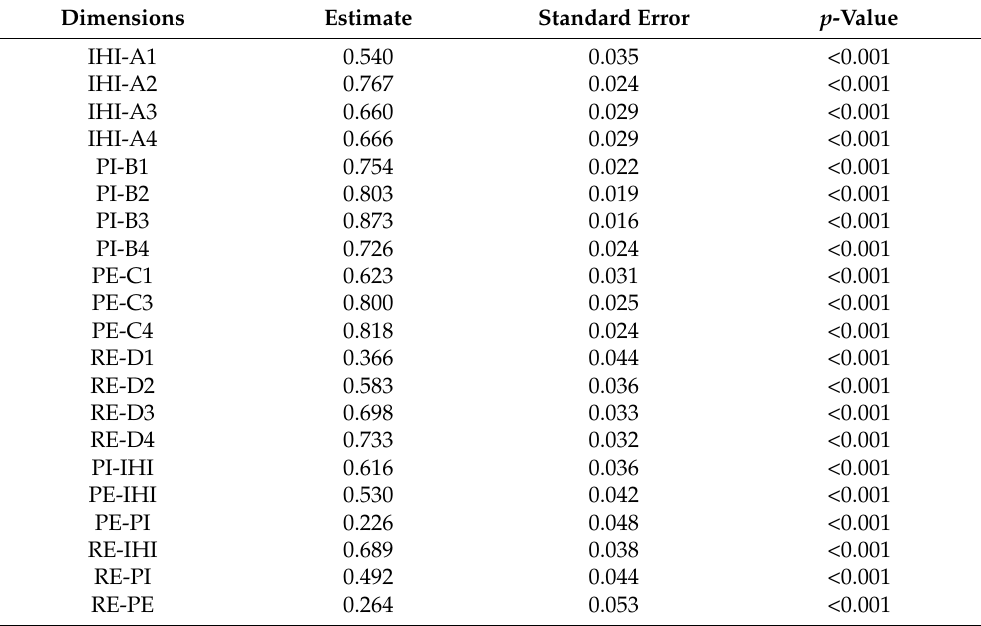
Table 2. The results of standardized estimates for DEFS